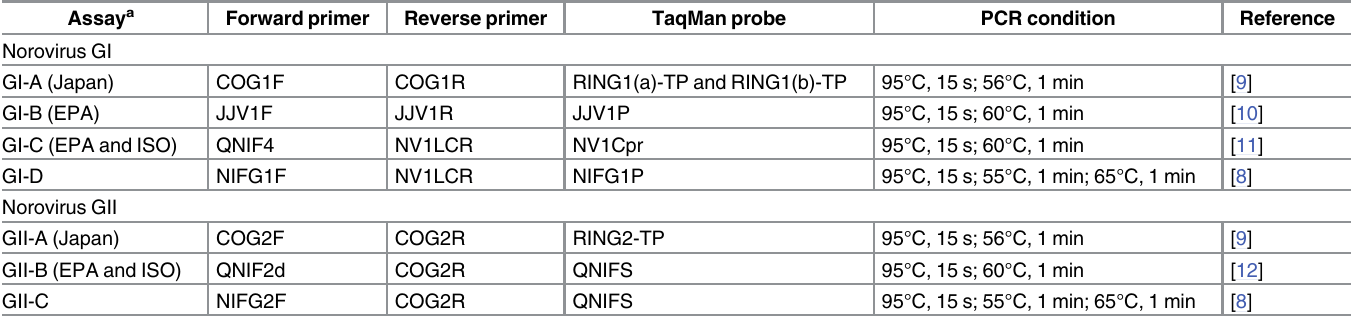
Table 1. Quantitative polymerase chain reaction assays used in the